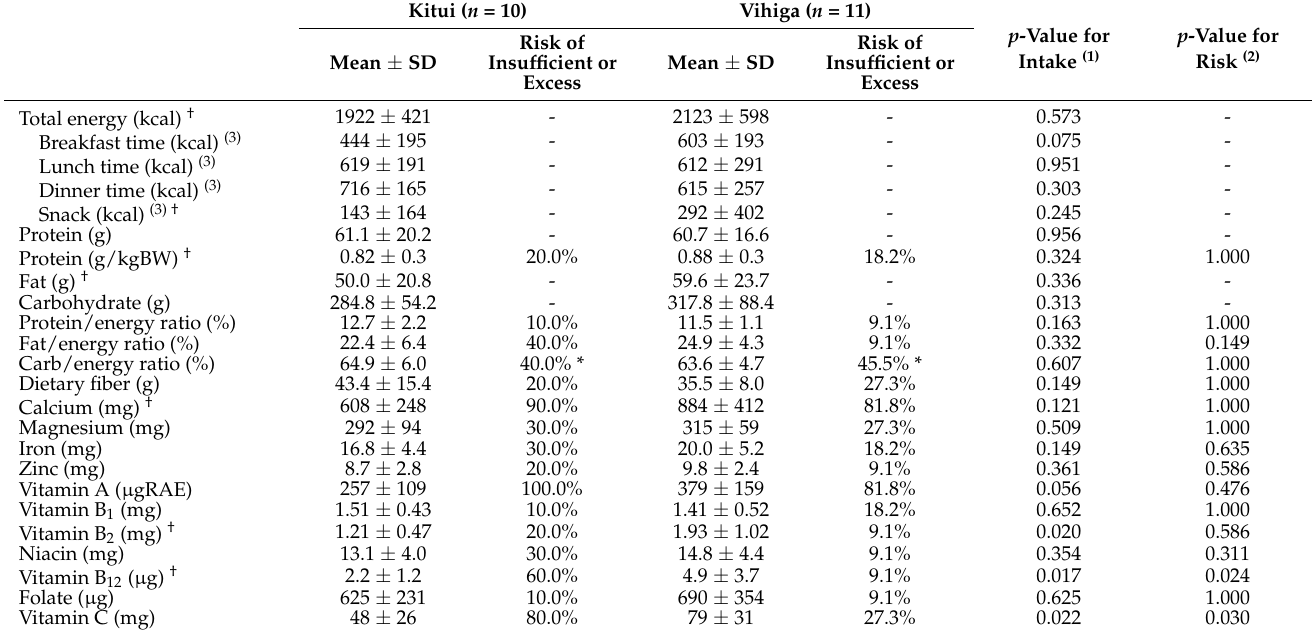
BW: body weight, Carb: carbohydrate, RAE: retinol activity equivalents, Values are expressed as mean ± SD or percentage of those who did not meet acceptable macronutrient distribution ranges (AMDR), estimated average